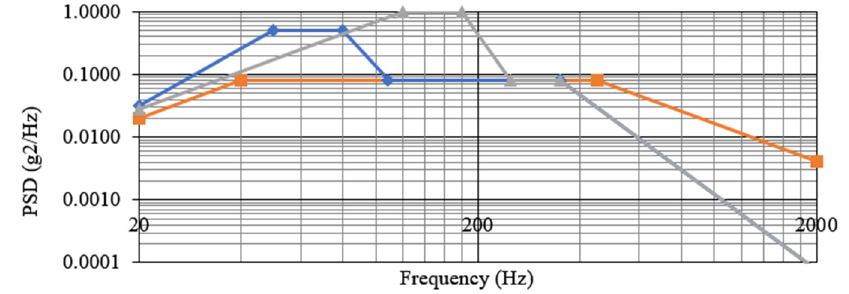
Figure 17. Random vibration profiles comparison. The orange line represents the initial requirement before isolation and the final profile performed over the shock absorbers with the dummy. The blue line represents the new profile for RDS-alone z-axis testing. Greyline represents the new profile for in-plane testing .